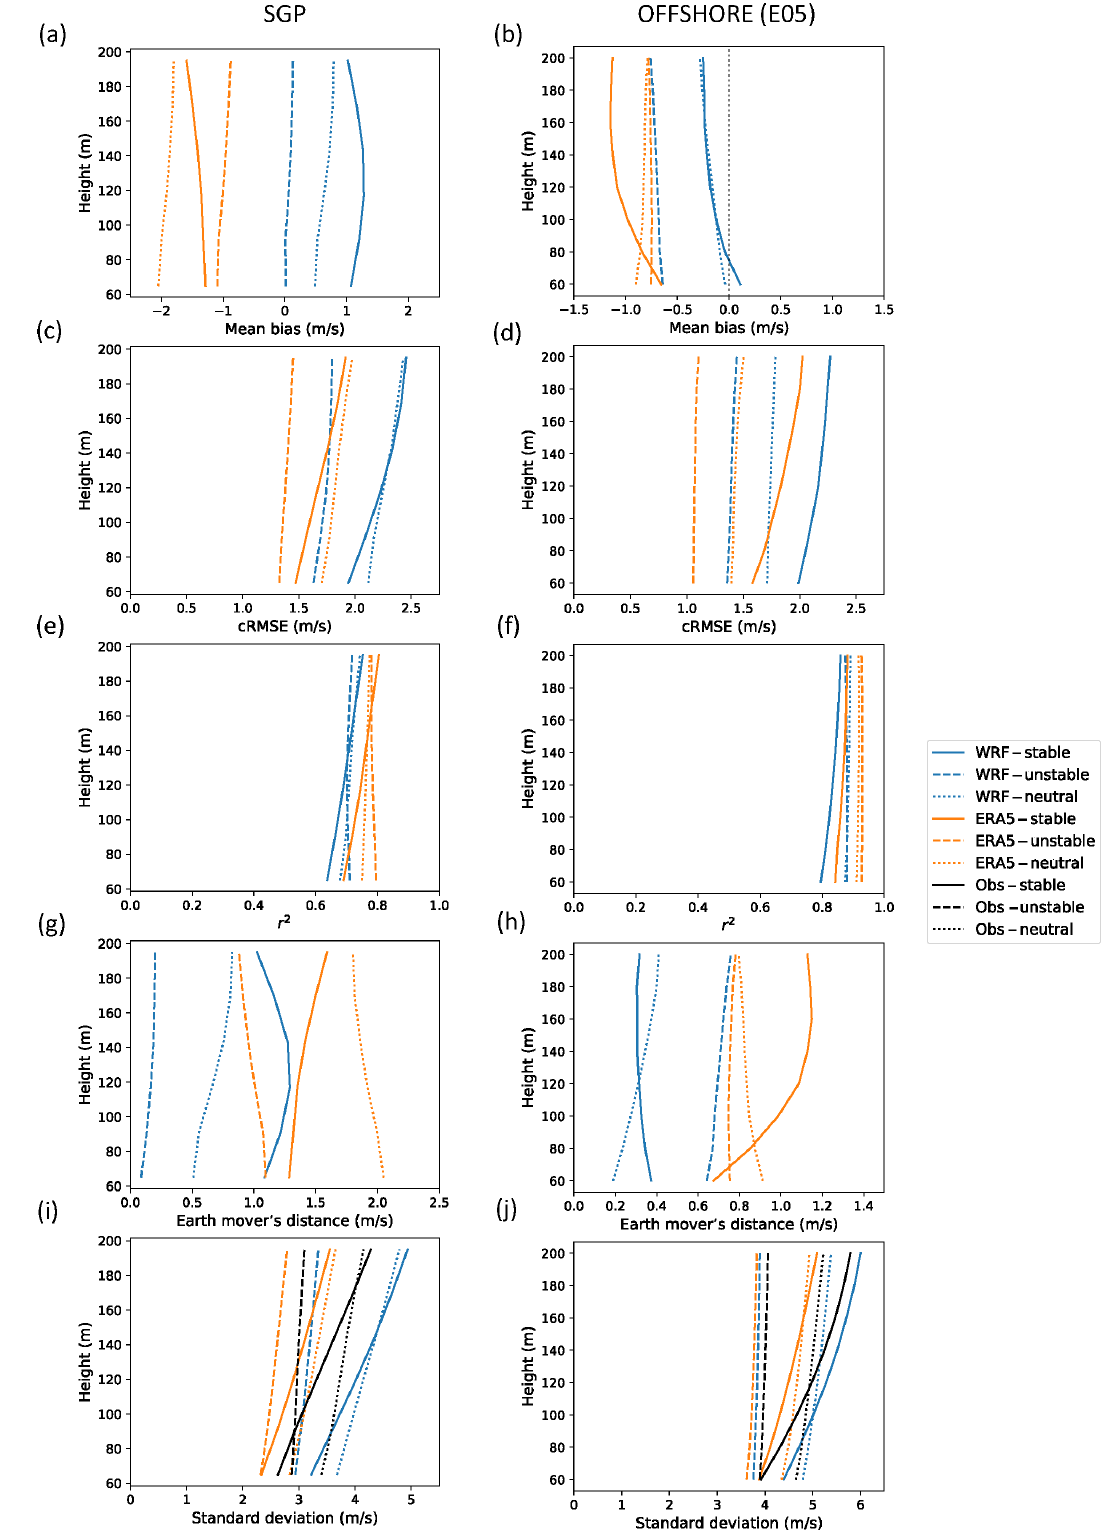
Figure 6. Vertical profiles of performance metrics segregated by atmospheric stability at the SGP C1 site (left) and at the location of the E05 lidar (right). Results from the E06 lidar are included in the